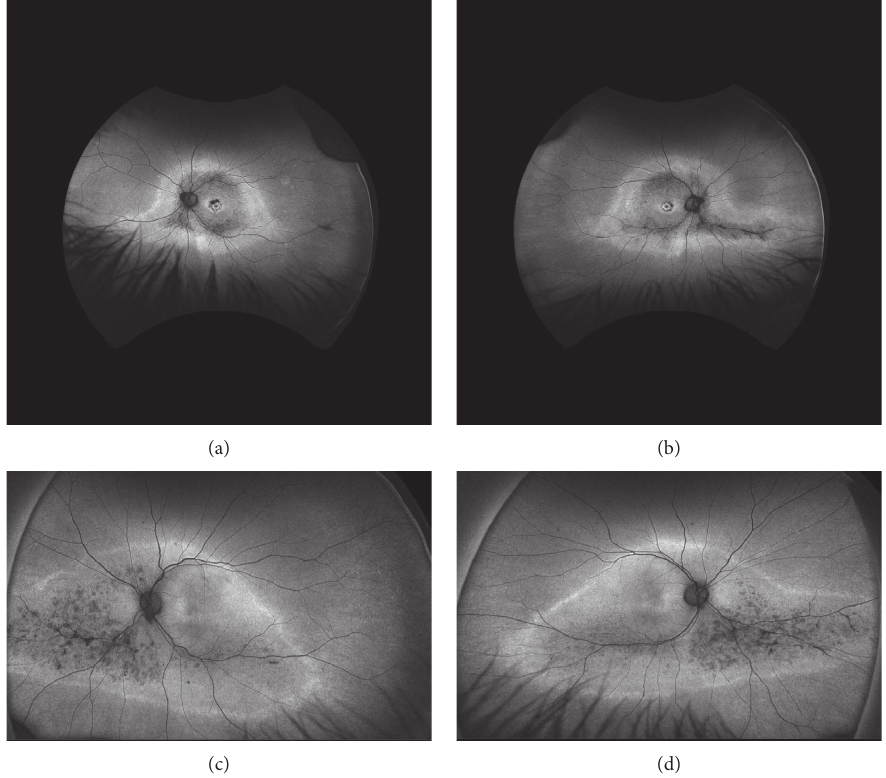
Figure 2: Ultra-wide-field fundus autofluorescence (UWF-FAF): (a) and (b) images of the patient’s right eye and left eye, respectively, showing macular autofluorescence changes in a bull’s-eye pattern OU with a midperipheral ring of hyperautofluorescence, denoting the border between the functional and dysfunctional retina. (c) and (d) Images of the offspring’s right eye and left eye, respectively, lacking the bull’s-eye pattern of the maculae that was present in his mother but showing a relative increase in the area of the dystrophic